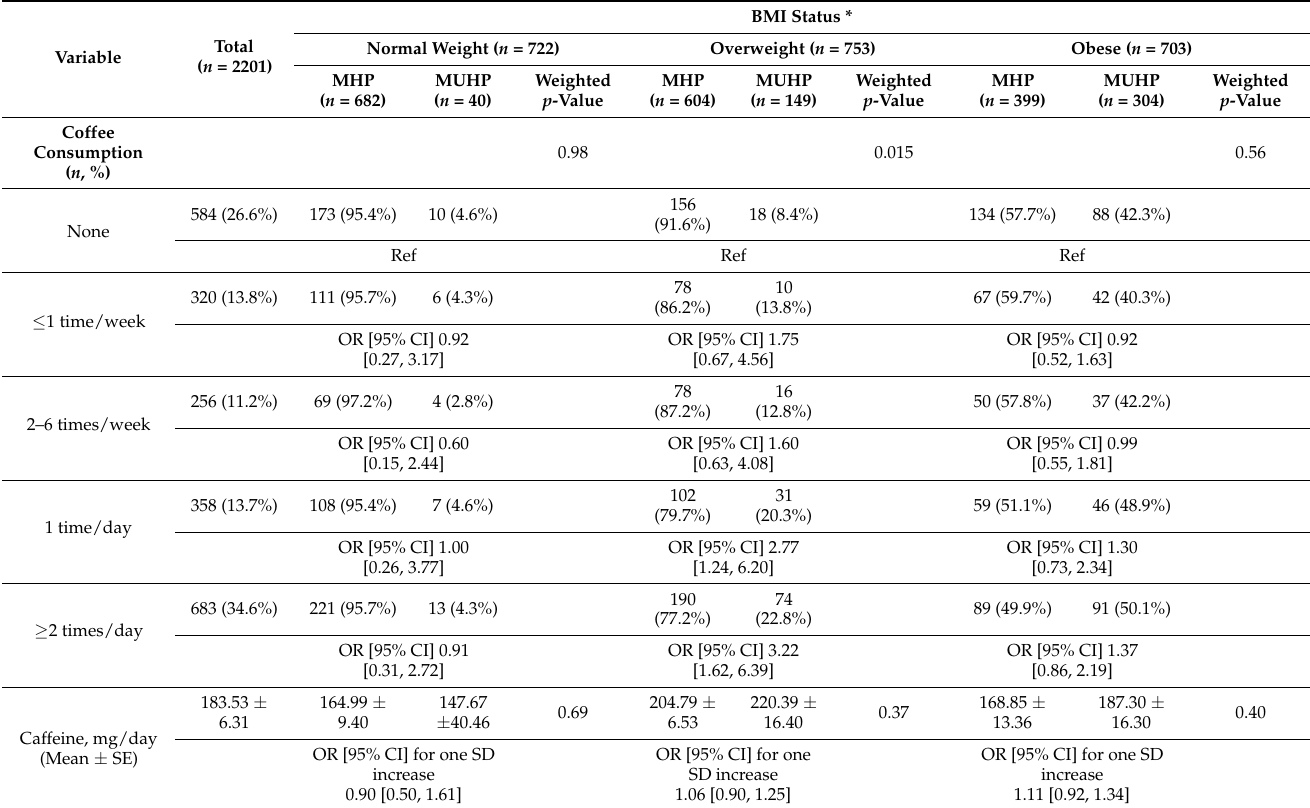
Table 4. Associations between coffee consumption, caffeine intake, and metabolic phenotypes based on BMI status.